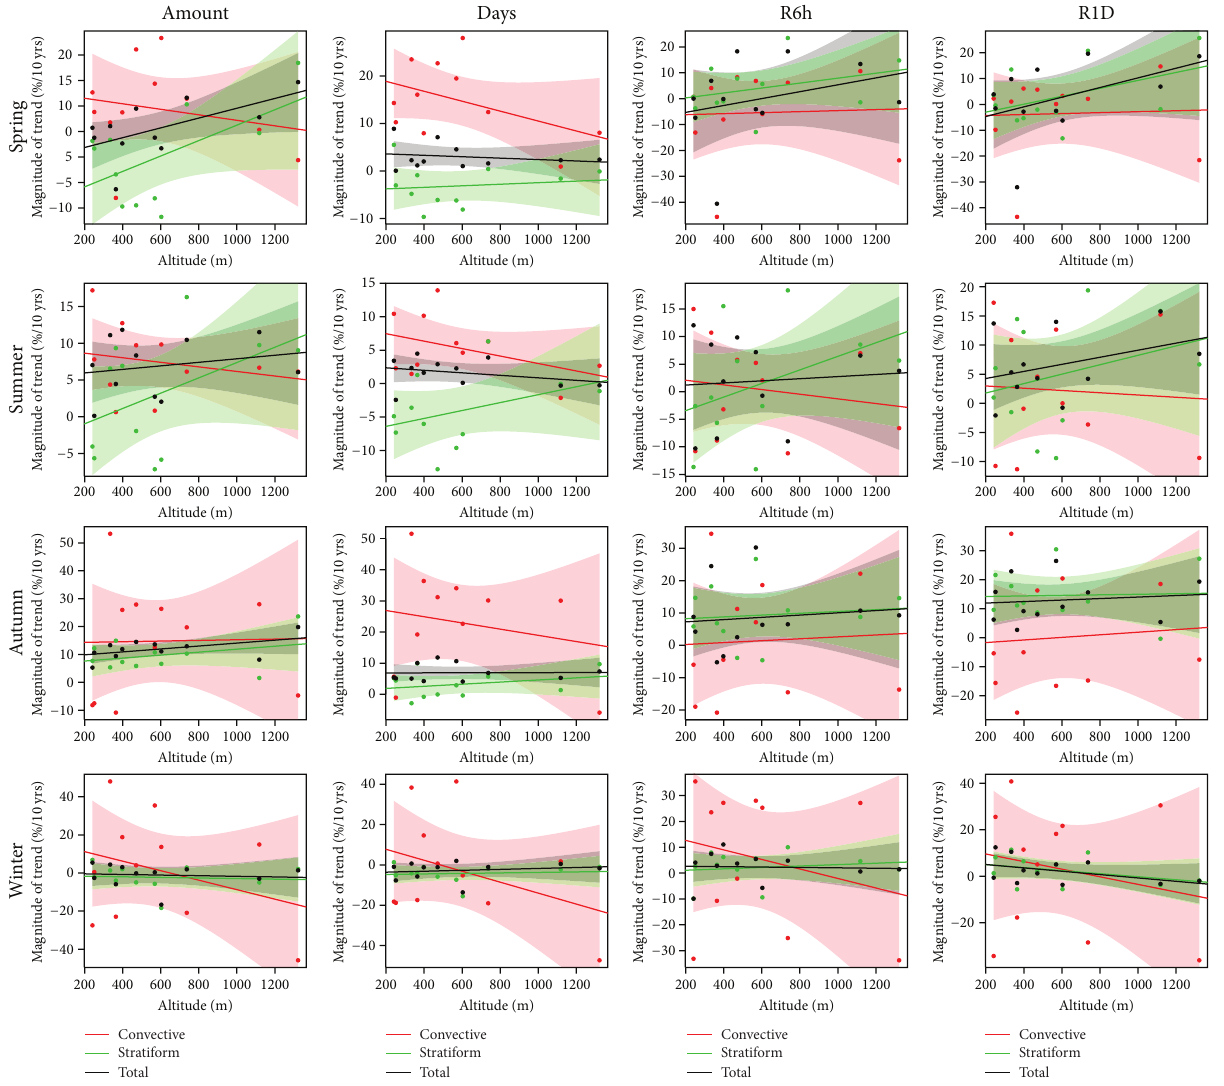
Figure 3: Dependence between trend magnitudes and altitude for characteristics of convective, stratiform, and total precipitation. Trends estimated by the linear regression and their 95% confidence bounds are